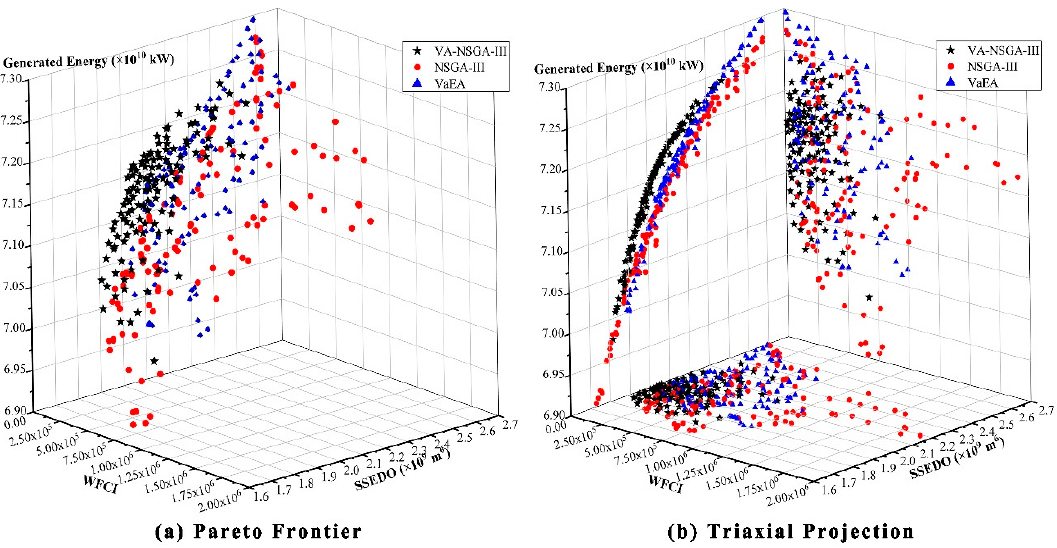
Figure 4. The Pareto frontier and tri-axial projections of the three